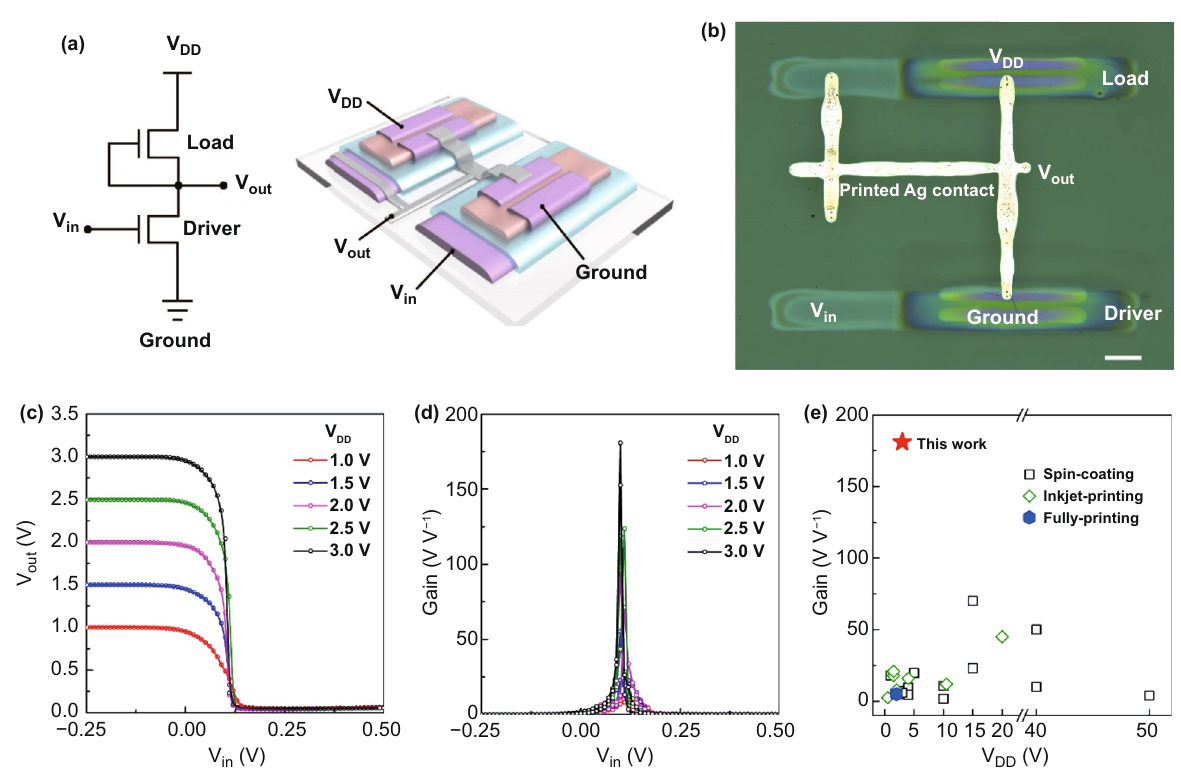
Fig. 5 Fully inkjet-printed NMOS logic inverter based on ITO TFTs. a Circuit diagram and schematic illustration of the NMOS inverter struc- ture. b An optical image of logic inverter based on two ITO TFTs connected by inkjet-printed silver contacts. Scale bar: 200 µm. c Input–out- put ( V in –V out ) voltage characteristics of the inverter under various supply voltages. d Corresponding gains of the NMOS inverter, showing a maximum gain of 181 at V DD = 3 V. e Benchmark of inverter performance as a function of supply voltage for inverters based on metal oxide semiconductor TFTs with different solution-processing techniques and the fully inkjet-printed ITO TFTs in this work. The data were taken from Table